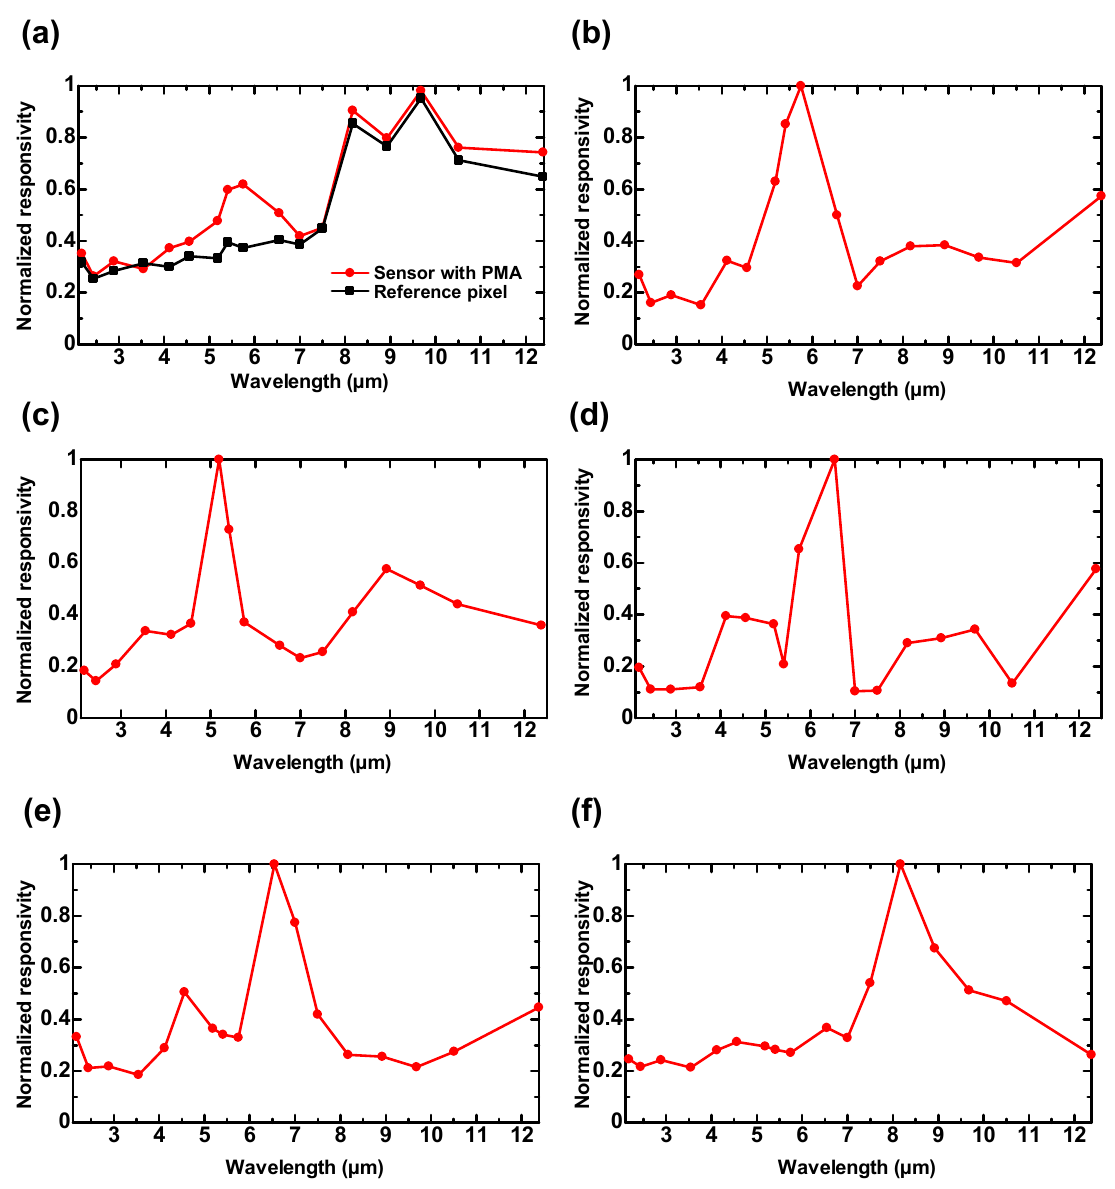
Figure 6. Normalized spectral responsivity: ( a ) of the sensor with PMA and the reference pixel, ( b ) after the subtraction operation for sensor B ( p = 5.5 μ m and d = 4.0 μ m), ( c ) after the subtraction operation for sensor A ( p = 5.0 μ m and d = 4.0 μ m), ( d ) after the subtraction operation for sensor C ( p = 6.0 μ m and d = 4.0 μ m), ( e ) after the subtraction operation for sensor D ( p = 6.5 μ m and d = 4.0 μ m), and ( f ) after the subtraction operation for sensor E ( p = 8.0 μ m and d = 7.0 μ m).